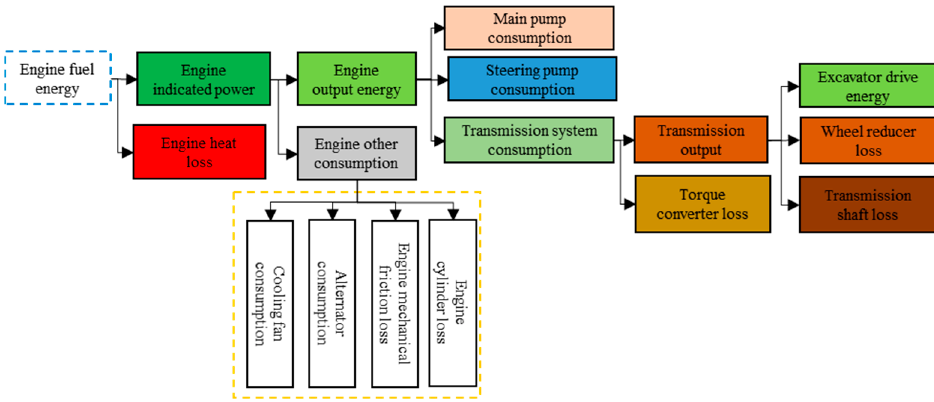
Figure 6. Excavator transportation condition energy flow.